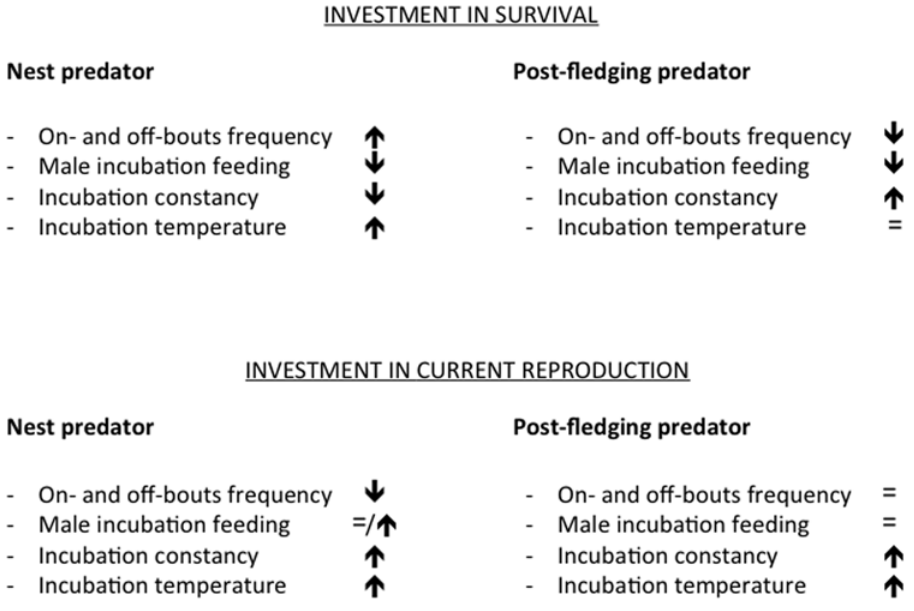
Fig 1. Summary of the predictions for the two maternal predator